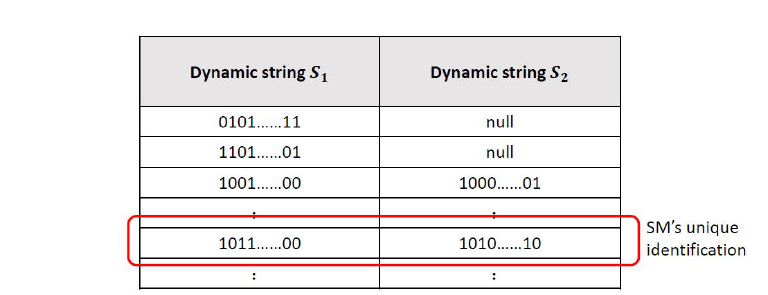
Figure 6. The dynamic verification table.